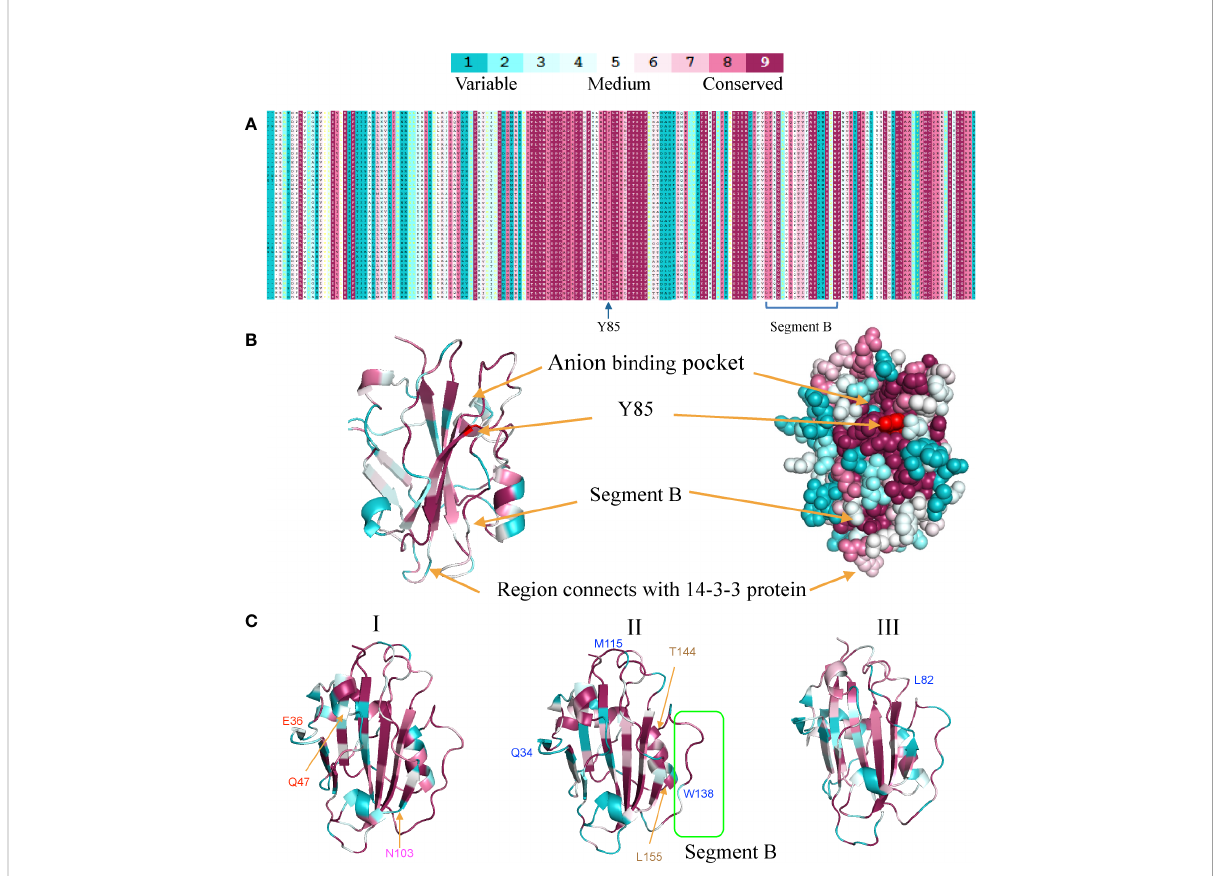
FIGURE 4 Sequence conservation and variation among three FT clades in monocots. (A) . Multiple-sequence alignment of the FT gene family. (B) Homology modeling of the FT gene family shows the conservation degrees (displayed in different colors) of different regions. (C) Conservation differences among three monocot FT gene clades using ribbon diagrams. Positive selection sites (BEB value >0.9) also marked in three clades. All the fi gures were generated using the PyMol script with the output of ConSurf as input. Blue marks represent positive selection sites with clade I Red marks represent positive selection sites in clade I-1, magenta marks represent positive selection sites in clade I-2, and coffee marks represent positive selection sites in clade